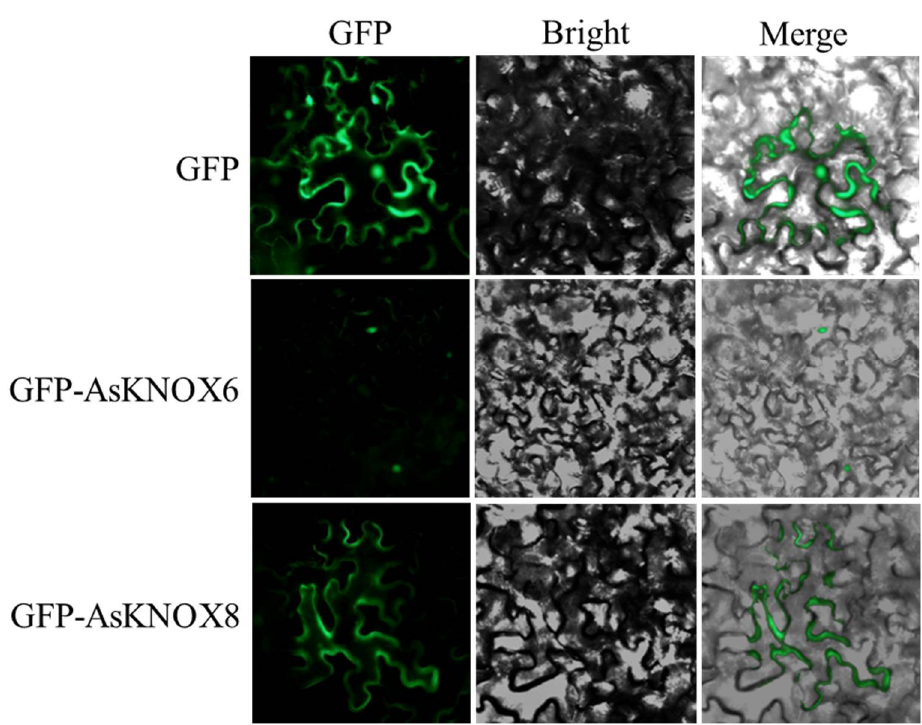
Figure 8. Subcellular localizations of AsKNOX8 and AsKNOX6 proteins. Both the GFP protein and the fusion proteins GFP-AsKNOX8 and GFP-AsKNOX6 were transiently expressed in the epidermal cells of tobacco leaves. Green fluorescence, bright-field, and merged images were orderly shown from left to right.